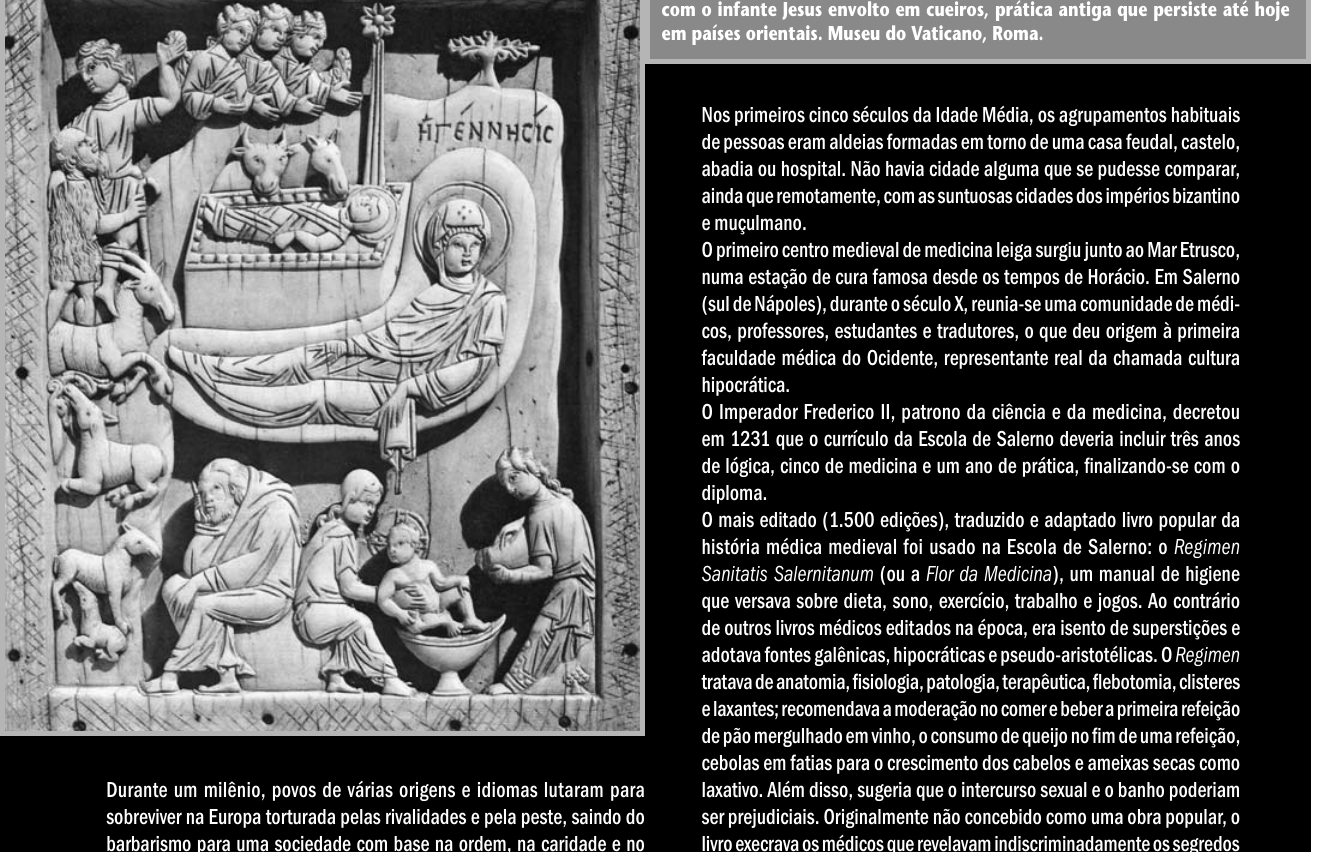
integrado às questões e aos relatos sociais brasileiros. Da mesma maneira que atendia à corte, produzindo gravuras que retratavam o cerimonial cotidiano dos nobres e atendendo pessoalmente a D. Pedro I, sentia-se intimamente ligado à vida da cidade, com seus escravos e senhores, hábitos, costumes e tradições. Em aquarelas, gravuras e litogravuras, Debret foi precioso na descrição visual da vida urbana do Brasil do início do século XIX, revelando – sem pudor, mas sem exageros – a realidade da escravidão, os castigos aos negros trazidos da África, a miscigenação que se iniciava e até mesmo a dificuldade experimentada pelos negros já